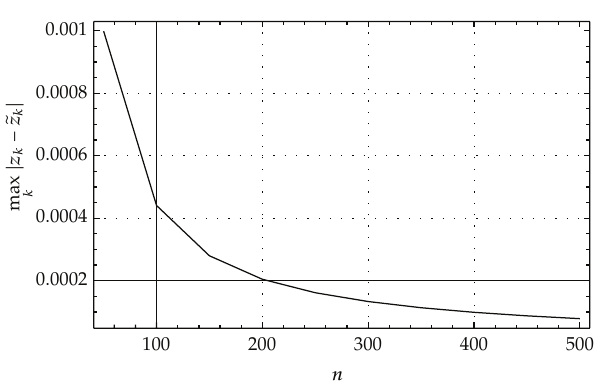
| z k − (cid:2) z k | against n for the case of a (cid:4) 1